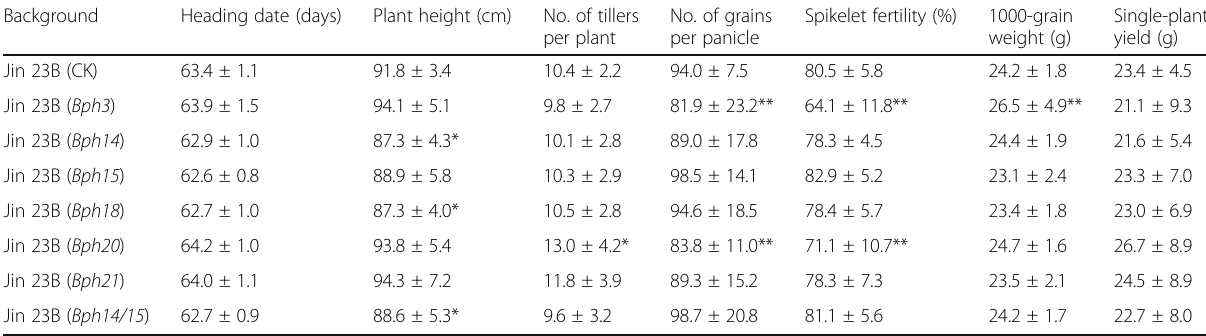
Table 2 Agronomic traits of improved Jin 23B lines with BPH resistance genes